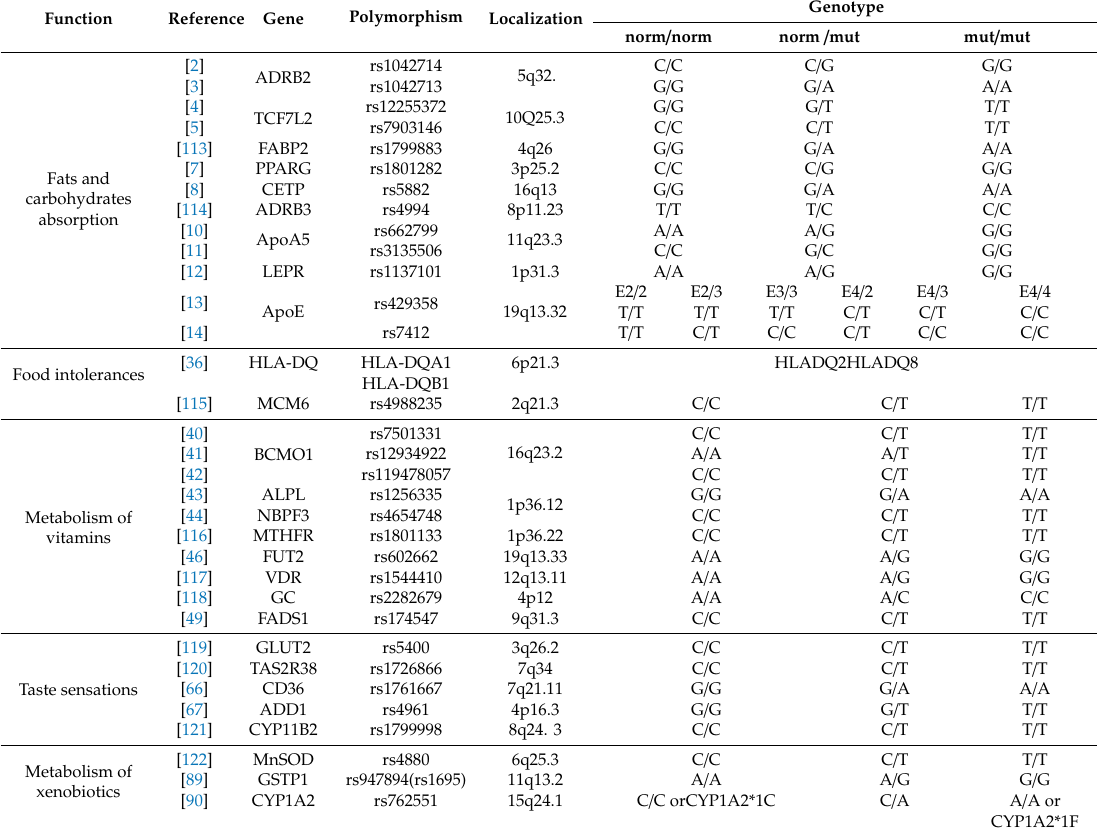
Table 8. List of genes and polymorphisms responsible for eating